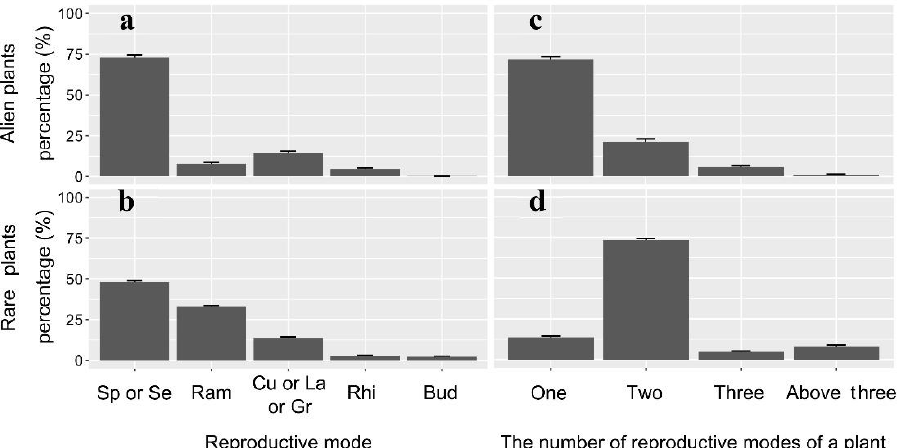
Figure 2. Percentage of reproduction modes and the number of reproduction modes of a plant. Percentage of reproductive mode of alien plants ( a ) and rare plants ( b ); percentage of the number of reproduction modes of a plant of alien plants ( c ) and rare plants ( d ). Sp or Se, spore or seed; Ram, ramet; Cu or La or Gr, cutting or layering or grafting; Rhi, rhizome; Bud, budding; One, one mode; Two, two modes; Three, three modes; Above three, more than three modes. Error bars represent standard error .